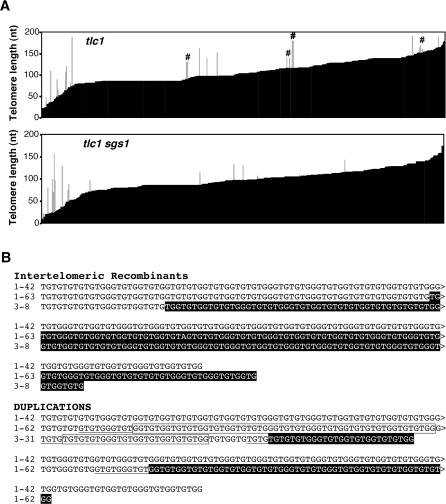
Analysis of Telomere Recombinants by DNA Sequencing(A) Lengths of PCR-amplified, cloned, and sequenced telomere repeat tracts from Chromosome I-L from tlc1 (top) or tlc1 sgs1 (bottom) mutant cells are arranged according to the length of nonrecombinant sequences. Nonrecombinant and recombinant tracts are indicated in black or gray, respectively. A total of 434 clones from tlc1 cells and 439 clones from tlc1 sgs1 cells were analyzed; the two cell types were sibling spore products and were analyzed at 43.8 and 43.4 PDs after spore germination, well prior to the appearance of survivors. Repeat examples of recombinants that begin at the same position in the nonrecombinant sequence are indicated by a number sign (#).(B) Selected clone sequences from both strains are aligned starting with the first base of the telomere repeats; most of the sequences continue onto a second line (indicated by the greater than symbol [>]). Recombinant sequences are boxed in black. 1–42, 1–62 and 1–63 are tlc1 clones, and 3–8 and 3–31 are tlc1 sgs1 clones. Sequence 1–42 is the longest nonrecombinant sequence (178 nt) from the two sets and was used as the reference sequence (the longest tlc1 sgs1 clone over its entire length matched the 1–42 sequence; unpublished data). Recombinants classified as intertelomeric showed no sequence identity between recombinant tracts and 1–42 sequences, nor with a 263-nt clone derived from earlier generation cells. Recombinants classified as duplications showed identity between the recombinant tract and internal sequences that appear to have been copied (open boxes); underlined sequences indicate the extent of uncertainty of the start of the recombinant tract.